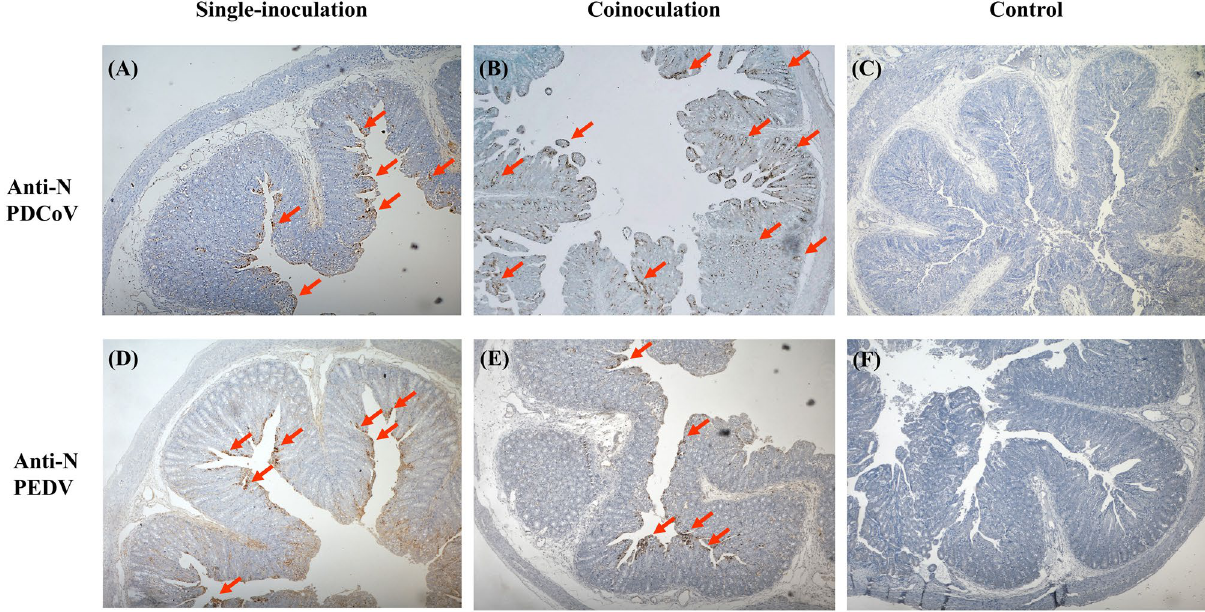
Figure 5. Immunohistochemistry (IHC) analysis (20X magnification) of small intestines of PDCoV-infected ( A ), PEDV-infected ( D ), co-infected ( B and E ), and control groups ( C and F ). Panels A to C were stained with anti-N PDCoV antibody. Panels D to F were stained with anti-N PEDV antibody. Red arrows represent enterocytes with positive signals for each